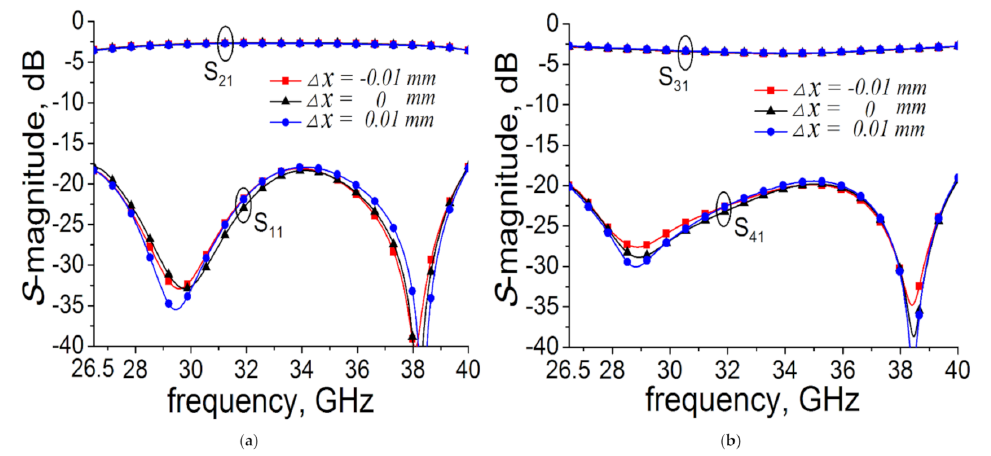
Figure 8. Sensitivity analysis: ( a ) S 11 and S 21 and ( b ) S 31 and S 41